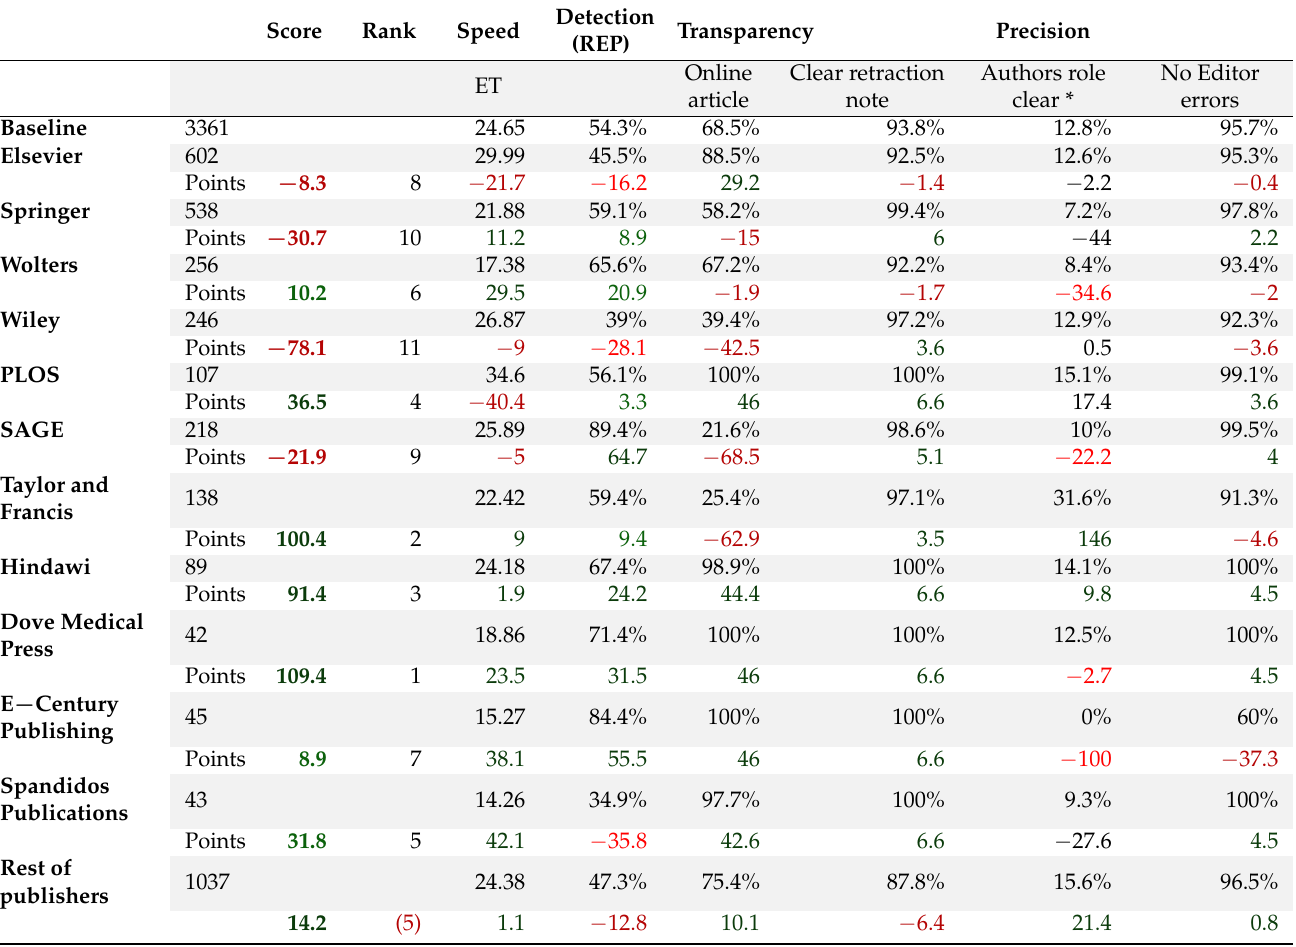
Table 14. SDTP scores and rank for the period 2009–2018 (n = 3361). * Calculated for 3037 articles with more than one author and no editorial errors as retraction reasons.